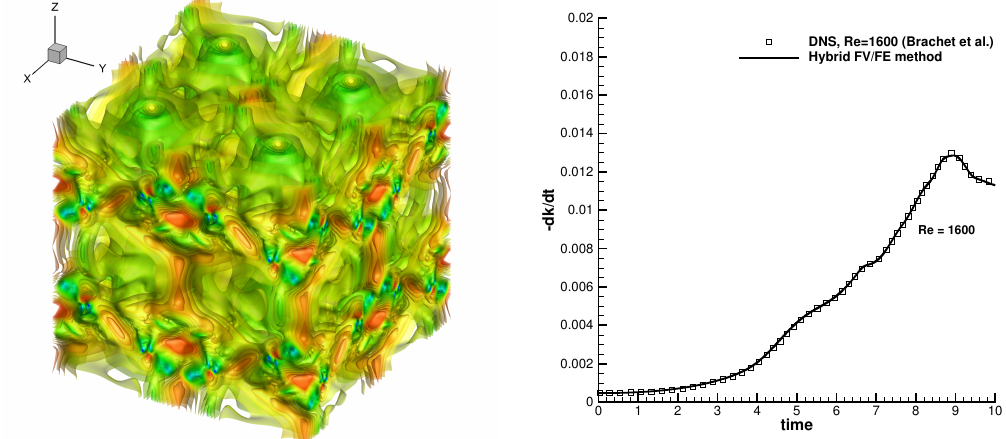
Figure 12. Three-dimensional Taylor-Green vortex with Re = 1600. Pressure isosurfaces at time t = 10 ( left ) and 1D plot of the total kinetic energy dissipation rate compared against the DNS data in [93] ( right